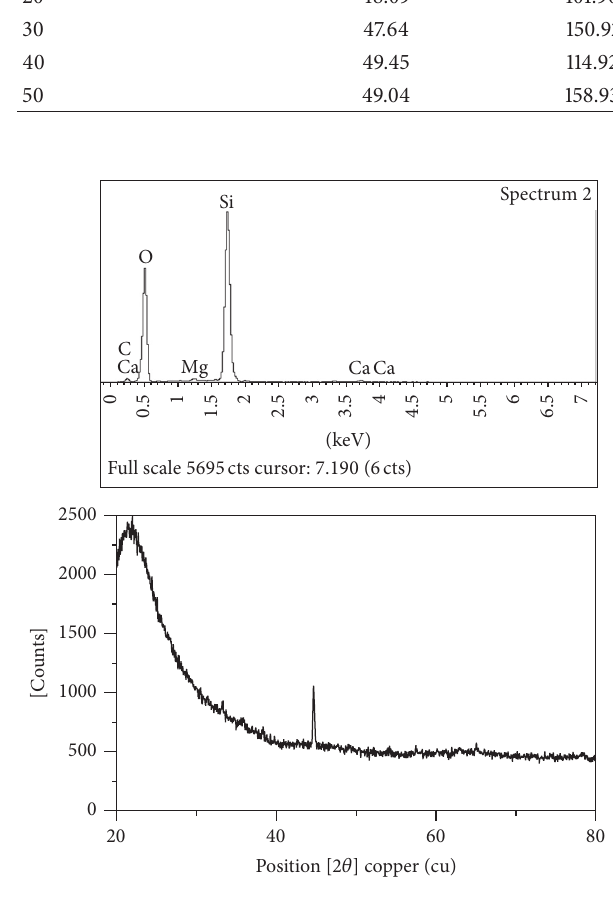
Figure 3: EDX and XRD for rice husk